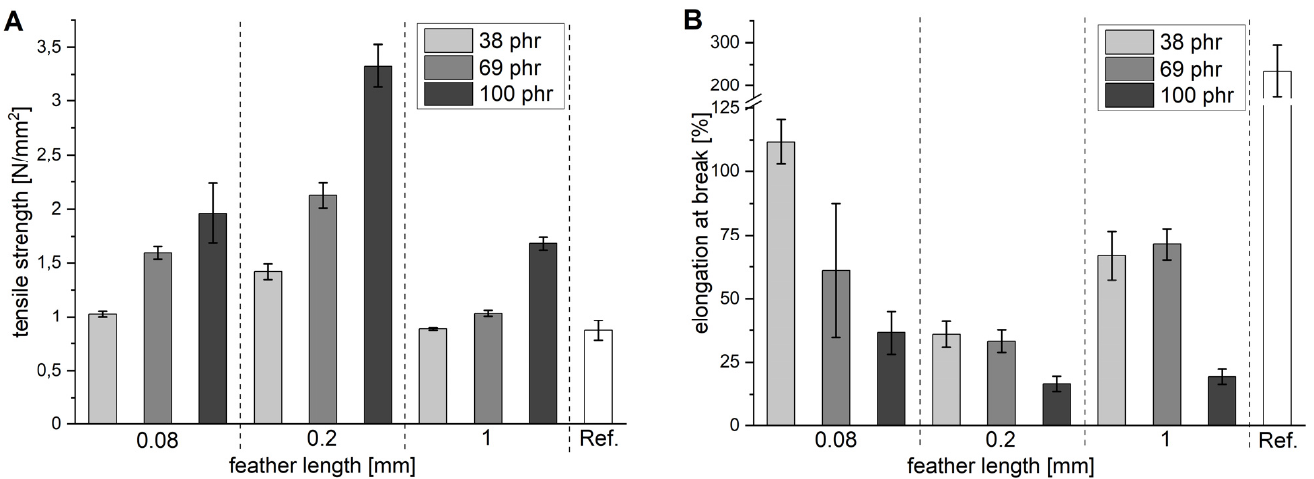
Figure 2. Tensile strength ( A ) and elongation at break ( B ) of the vulcanised EPDM mixture M1 as a function of the amount and length of the feather cuttings. Specimens were prepared from a single, 2 mm thick sheet. A vulcanised M1 mixture without feathers is used as reference. Note the interruption of the y-axis at the reference in ( B ).